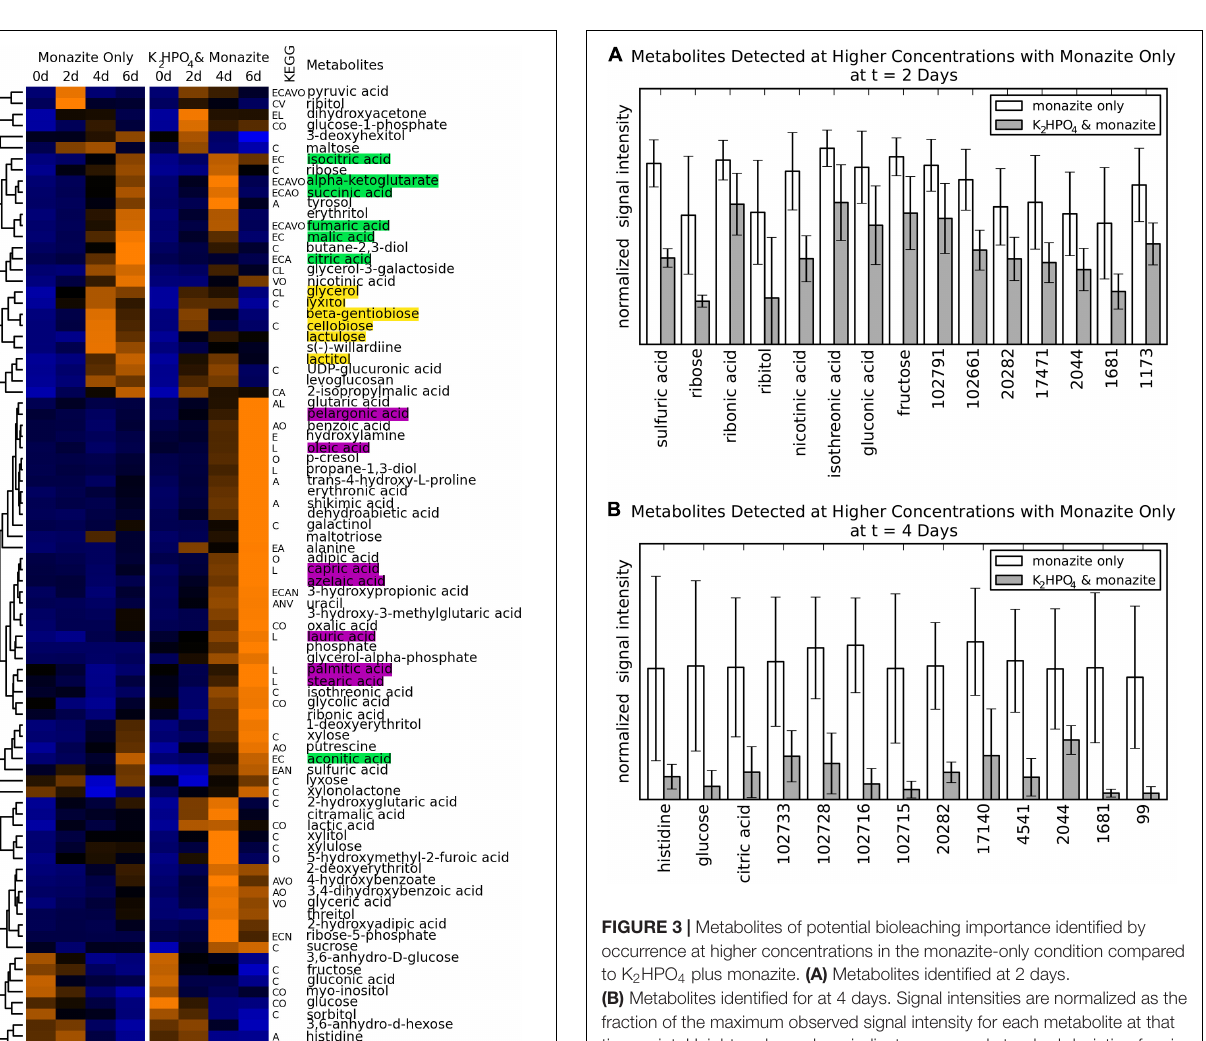
p-cresol, and stearic acid) were selected for further study, while three (glucose, sulfuric acid, and phosphate), were rejected for previously stated reasons.